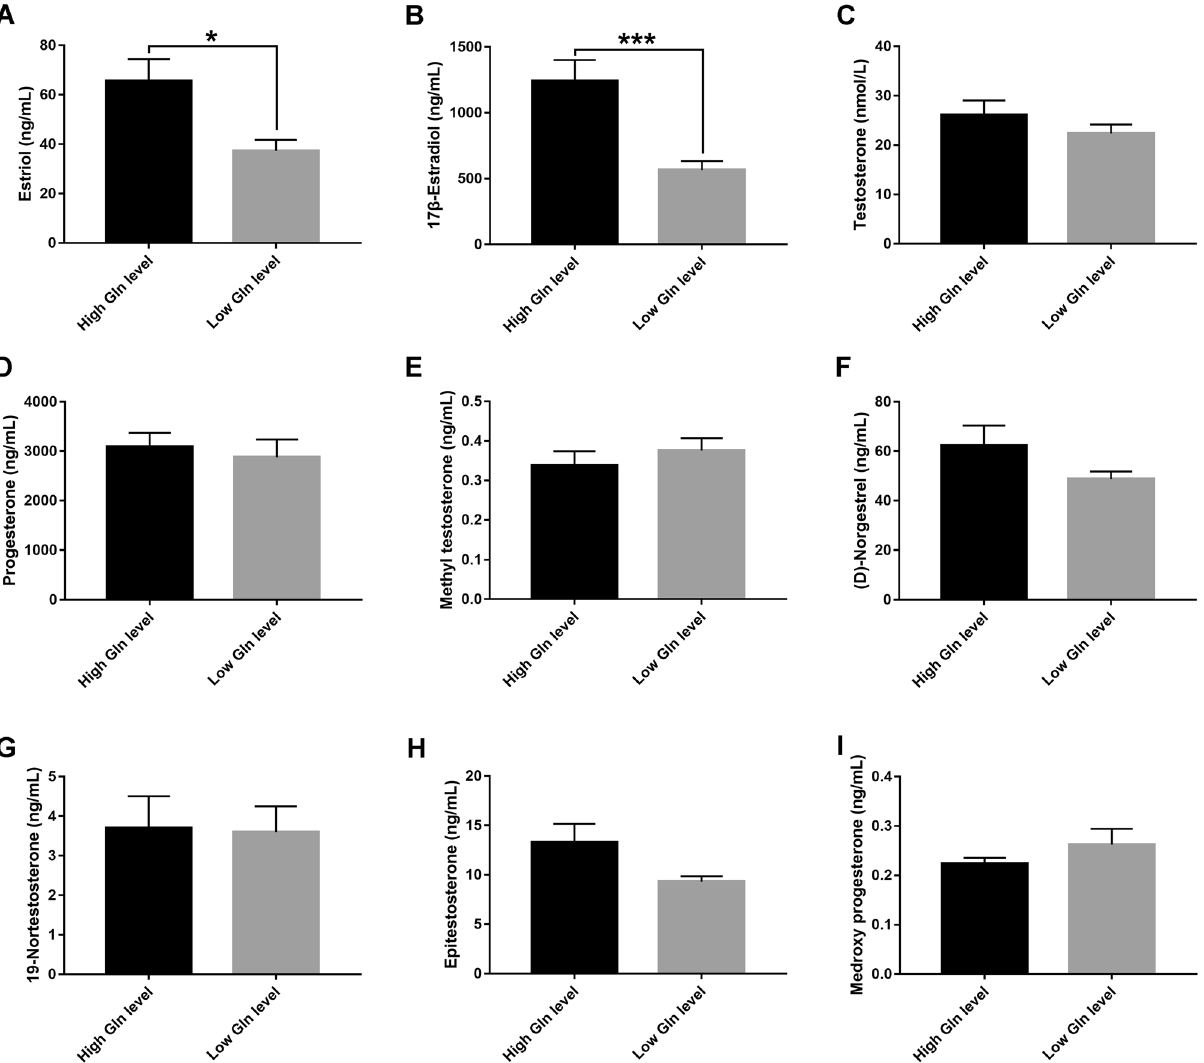
Figure 3. Metabolic levels of steroid hormones measured by HPLC–MS/MS in human follicular fluid. The graphs show kinds of hormone concentrations in human follicular fluid between high and low glutamine (Gln) level groups, including estriol ( A ), 17β-estradiol ( B ), progesterone ( D ), methyl testosterone ( E ), (D)-norgestrel ( F ), 19-nortestosterone ( G ), epitestosterone ( H ) and methoxy progesterone ( I ). ( C ) The column chart shows the concentration of testosterone in the follicular fluid in the two groups, which was measured by a chemiluminescence immunoassay. Data represent the mean values ± standard error of the mean (mean ± SEM). High Gln level group, n = 14; Low Gln level group, n = 13. All indicated P values were determined by Student’s t-test. * P value < 0.05; *** P value <